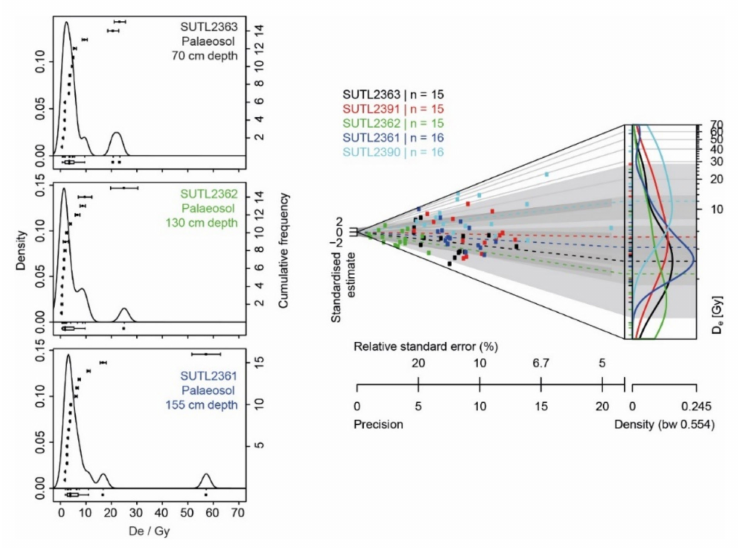
Figure 9. Equivalent dose distributions as Kernel Density Estimate (KDE) and Abanico plots for SUTL2361-2362-2363 (the palaeosols) and SUTL2390-2391 (the fluvial sands).